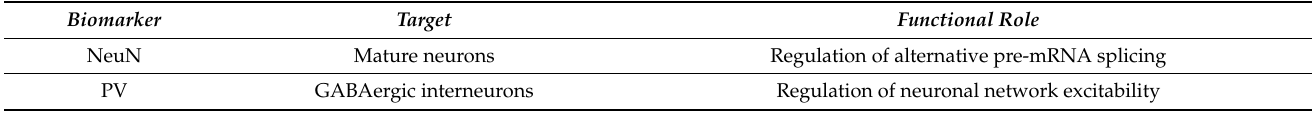
Table 3. List of potential biomarkers of neuronal injury and